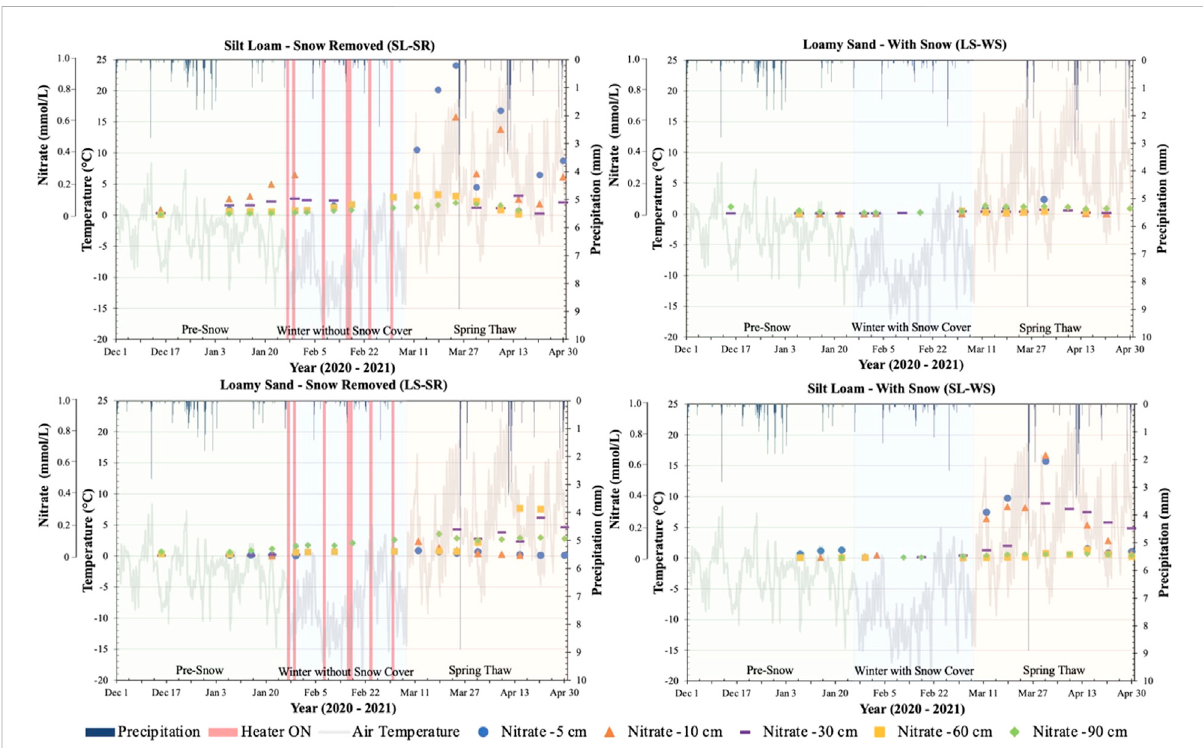
FIGURE 2 Porewater nitrate (NO 3 − ) concentration (tertiary y -axis) measured at -5, -10, -30, -60, and -90 cm depths in four lysimeters between 1 December 2020, and 30 April 2021. NO 3 − concentration is plotted with air temperature (primary y -axis) and precipitation (secondary y -axis) recorded from the Environment Canada Elora Weather Station. The graphs for SL-SR and LS-SR also show when the heaters were turned on and off duringthewintertomeltsnowonthelysimetersurface(redbarsonwinterwithoutsnowcoverphase).Thegraphsaredividedintothreephases, pre-snow, winter with/without snow, and spring-thaw, to determine the patterns of change during each of the experimental